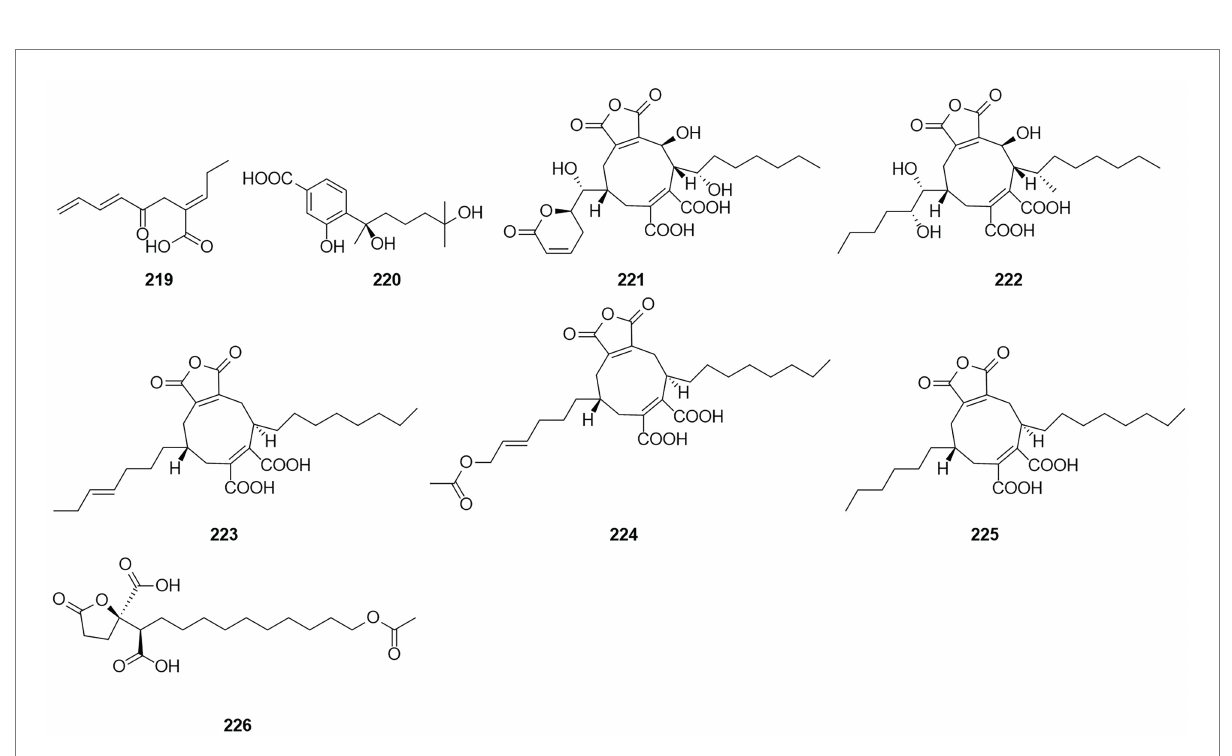
FIGURE 14 Chemical structures of compounds 219–226